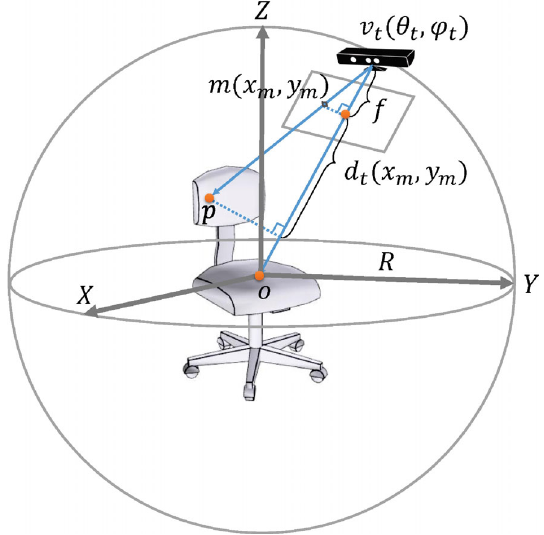
Fig. 3 Given a view v t = ( θ t ,ϕ t ), the depth value of a pixel d t ( x m ,y m ) in the corresponding depth image is parameterized with repsect to the view parameters and the position of the intersection point, p , computed by ray